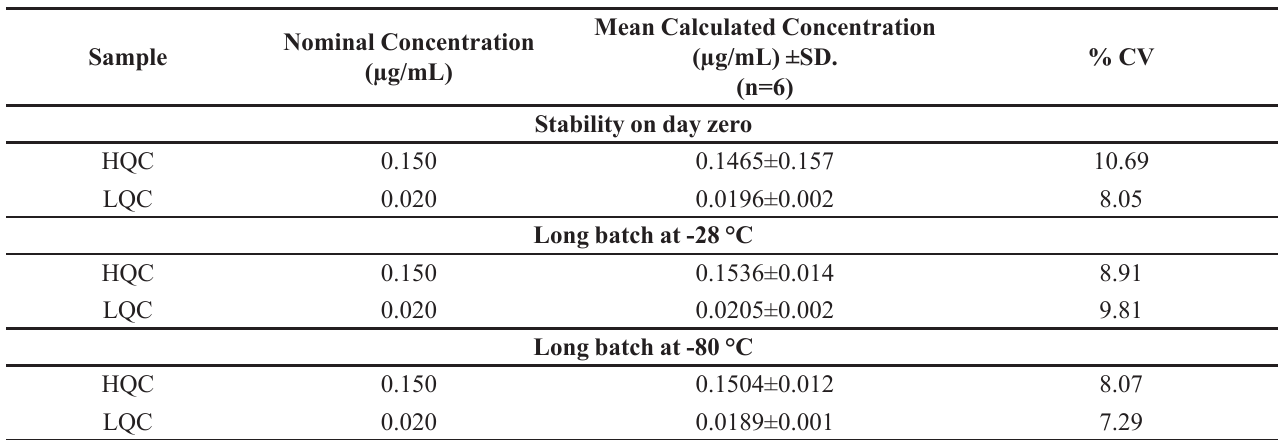
TABLE XI - Stability